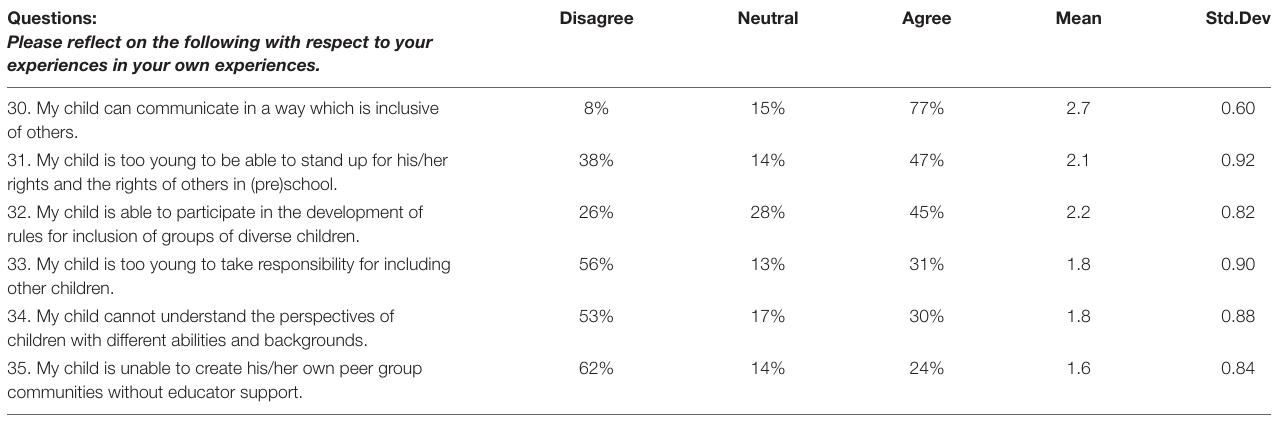
TABLE 12 | Scale 7 goal fulfilment.